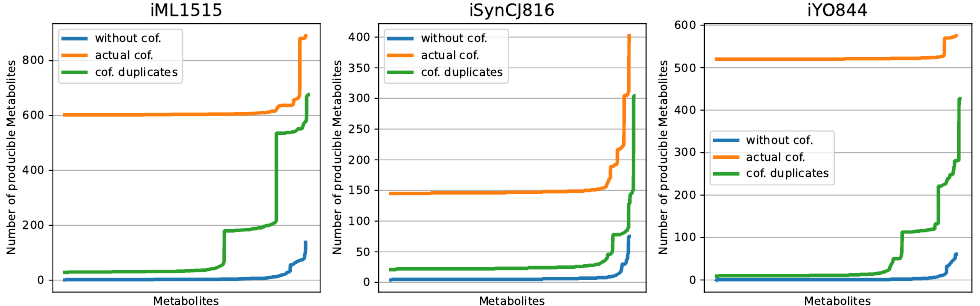
Figure 4. Metabolic scopes in established models of E. coli (iML1515), B. subtilis (iYO844) and Synechocystis sp. PCC 6803 (iSynCJ816). The differently colored graphs represent the same analysis but including no cofactors, actual cofactors and cofactor duplicates in the